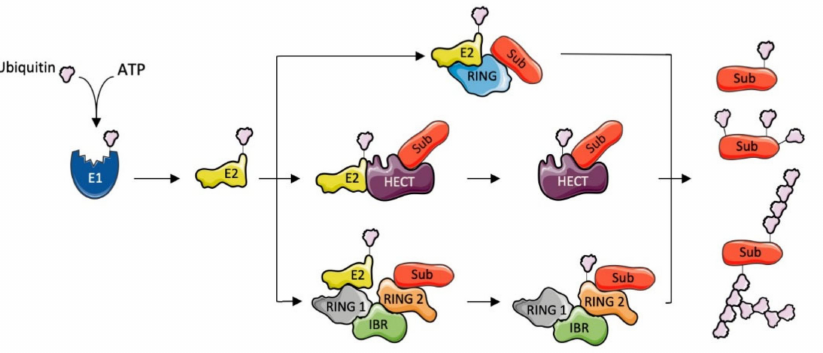
Figure 1. The ubiquitination process and E3 ubiquitin ligases. Protein ubiquitination is carried out by a ubiquitin (Ub)-activating enzyme (E1), a Ub-conjugating enzyme (E2), and a Ub-ligating enzyme (E3). The E1 activates Ub in an ATP-dependent manner through the formation of a thiol-ester bond; the activated Ub is transferred to the Cys-active site of an E2; the E3 facilitates ubiquitination of the substrate and defines substrate specificity. The different mechanisms of the three main classes of E3 Ub ligases is depicted. The HECT (homologous to the E6AP carboxyl terminus) domain-containing E3s form a thiolester with Ub, which is then transferred to the amino group of a substrate lysine. Non-HECT domain E3s containing a catalytic RING or RBR (RING-In between RING-RING) function as adaptors linking substrate and Ub-charged E2. Targeting different Ub lysines or Met1 for chain formation allows the generation of a great variety of distinct Ub modifications, including different homotypic chains, and mixed and branched